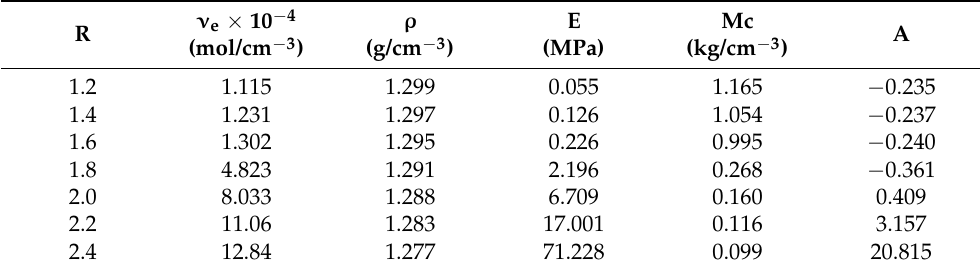
Table 3. Crosslink density and correction factor of polymer films with different